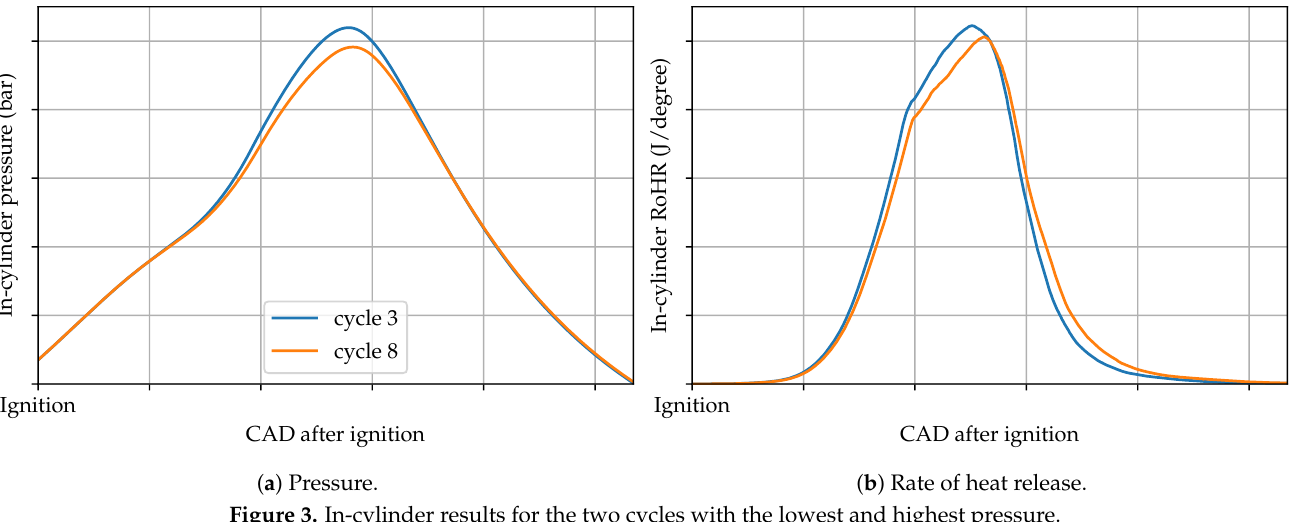
Figure 3. In-cylinder results for the two cycles with the lowest and highest pressure. Table 2 summarizes results for four combustion metrics for 16 simulations using the combinations listed in Table 1. Respectively, these metrics are peak cylinder pressure ( p max ), crank angle degree after ignition of peak cylinder pressure (CAD p ), crank angle degree max after ignition for 50% fuel mass fraction burned (MFB 50% ) and crank angle duration from